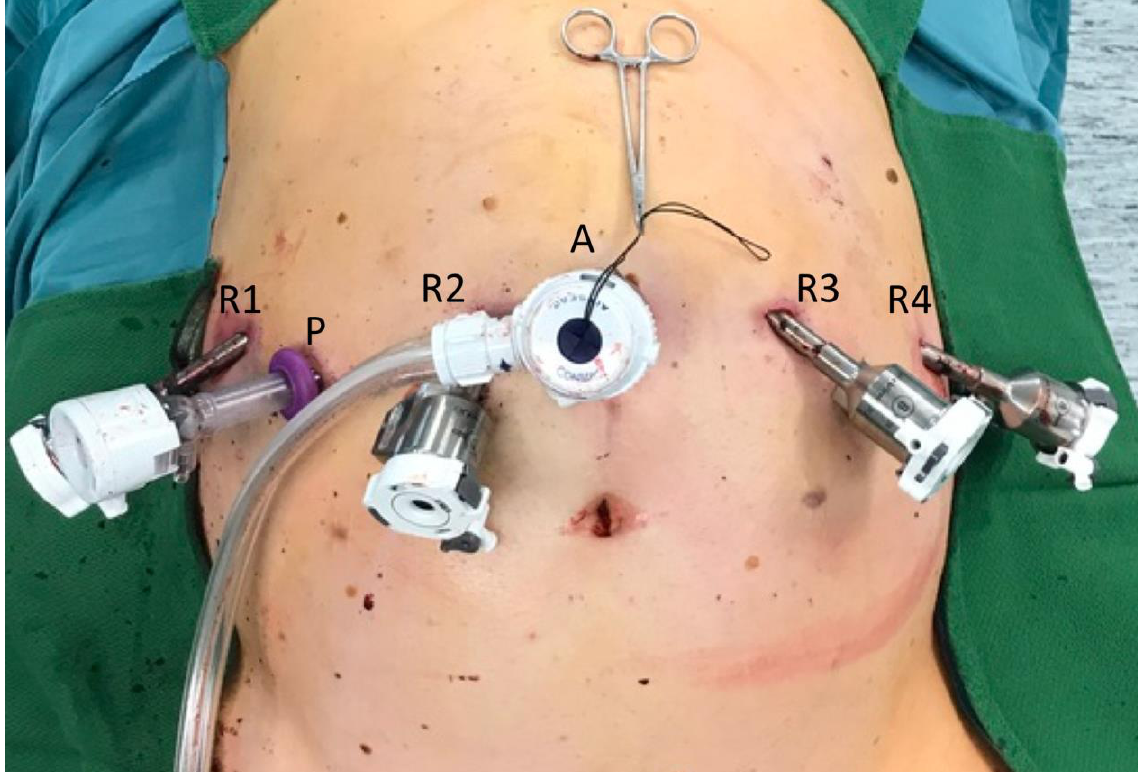
Figure 1. Trocar placement for robotic-assisted liver resection using the three device (3D) method for liver parenchyma dissection (DaVinci Xi System, Intuitive Surgical, Inc., Sunnyvale, CA, USA). R1: Robotic arm 1 used for bipolar Maryland forceps, R2: Robotic arm 2 used for camera, R3: Robotic arm 3 used for monopolar scissors, R4: Robotic arm 4 used for fenestrated grasp. A: Laparoscopic trocar for assistance from the table e.g., driving the waterjet (Erbejet ® 2, Erbe Elektromedizin GmbH, Tuebingen, Germany). P: Trocar for pringle maneuver.